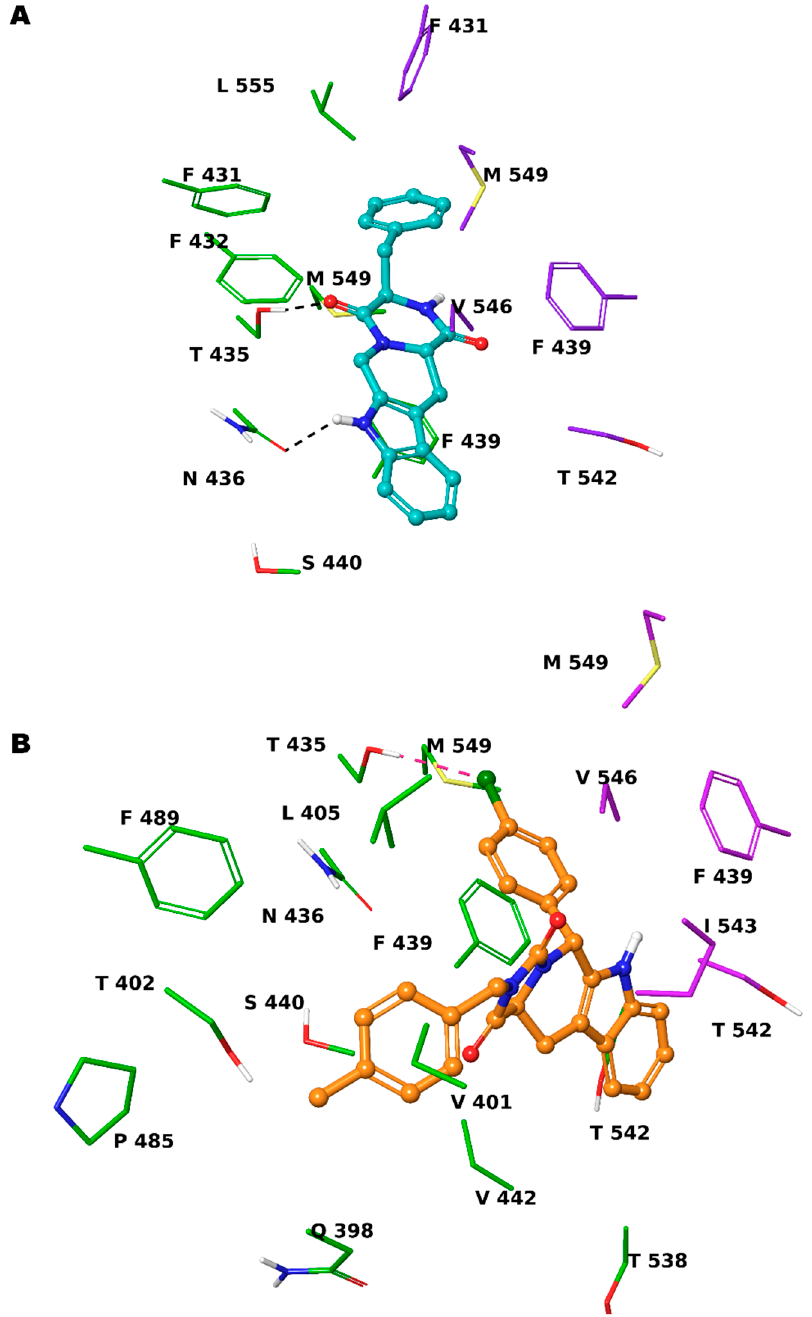
Figure 3. Three-dimensional model of the interactions given by 8 ( A ) and 13a ( B ) with ABCG2. The protein is depicted by tube, with the following color-code: C, green (chain A) and violet (chain B); polar H, white; N, dark-blue; O, red; S, yellow). The small molecules are represented by sticks (teal for 8 , orange for 13a ) and balls (colored: C, as for the sticks; polar H, white; N, dark-blue; O, red; Cl, forest green). The dashed green and pink lines indicate the hydrogen and halogen bonds, respectively, between the ligand and protein.